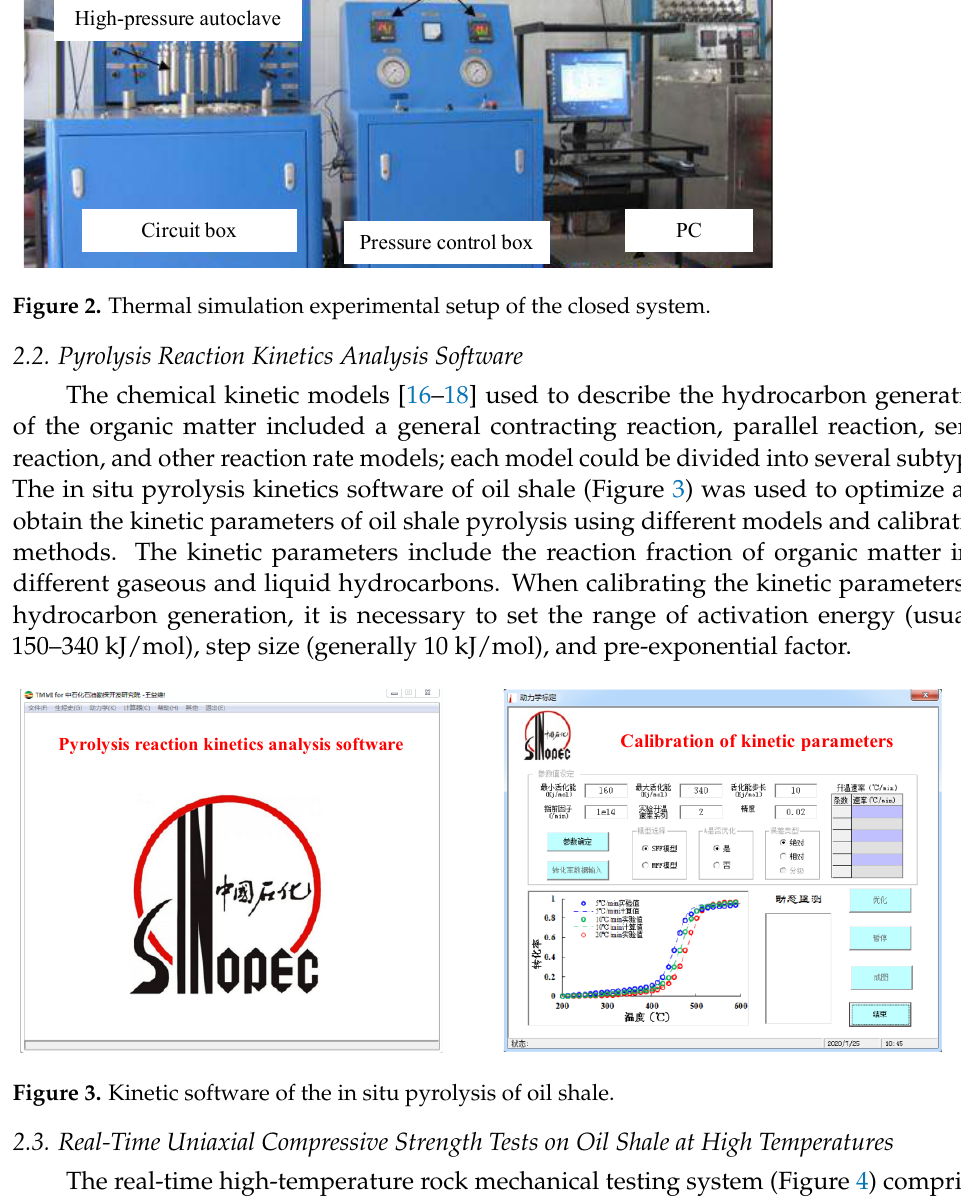
Figure 2. Thermal simulation experimental setup of the closed system.